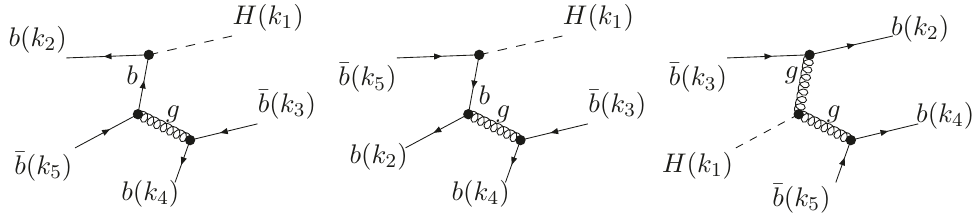
Figure 1 . Feynman diagrams at leading order for the Higgs boson decaying into four bottom quarks via Yukawa interactions. Diagrams can be obtained with interchanges of identical particles are not shown for